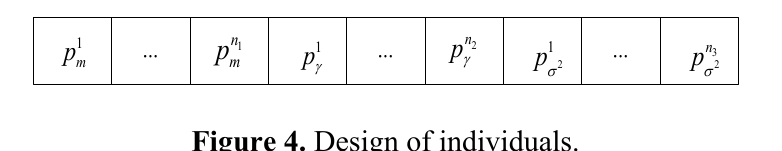
Figure 4. Design of